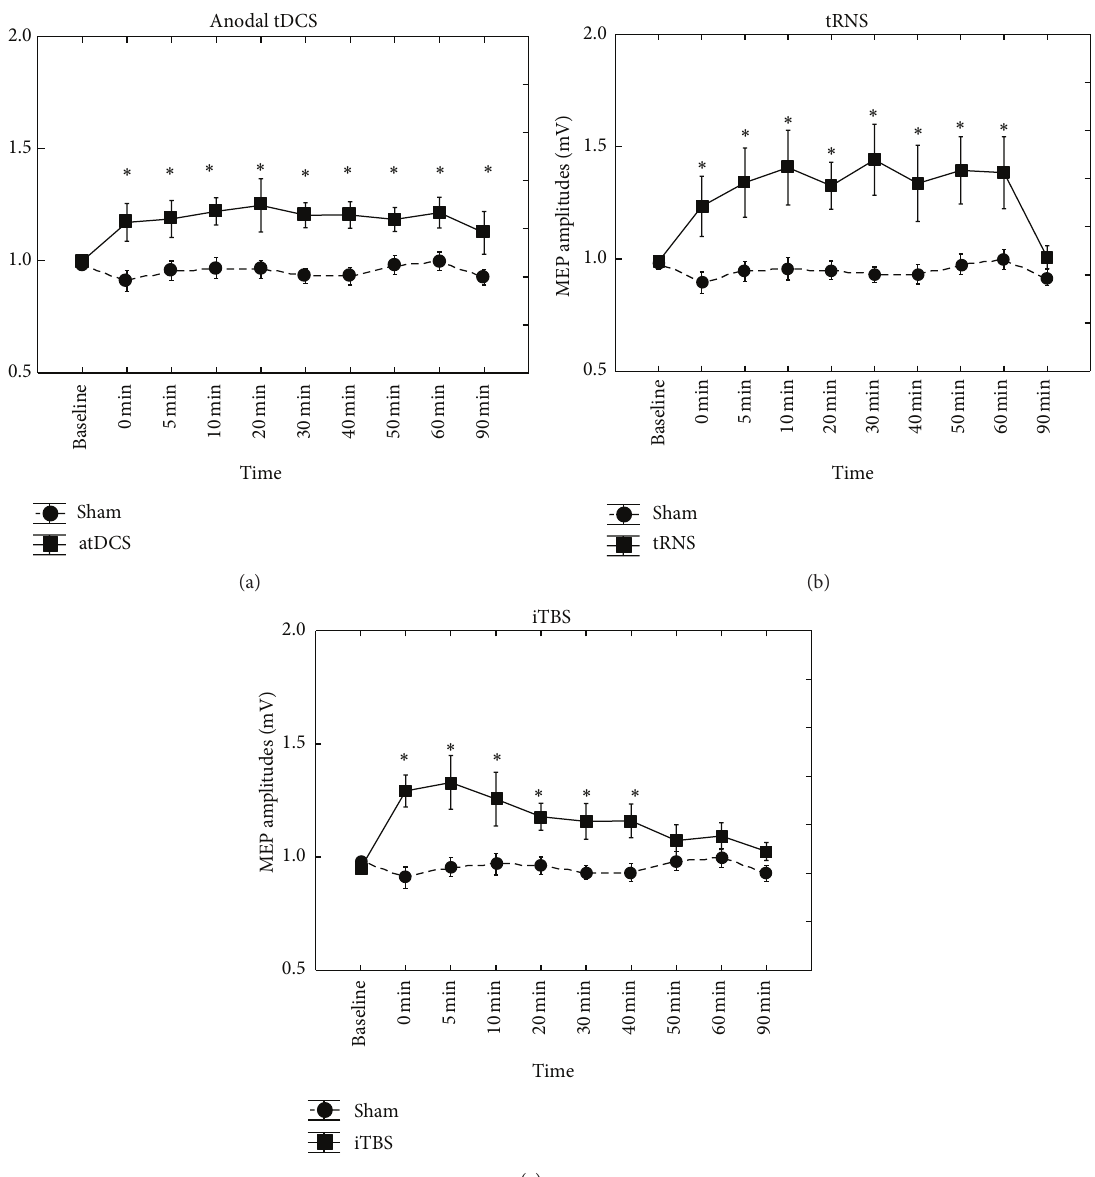
Figure 1: atDCS, full spectrum tRNS applied over the M1 using 10 min stimulation duration and 1mA intensity showed the classical behaviour and induced excitability increase. Similar pattern was seen by iTBS. Data are mean ( ± SEM) peak-to-peak amplitudes of MEP. An asterisk indicates that 𝑃 < 0.05